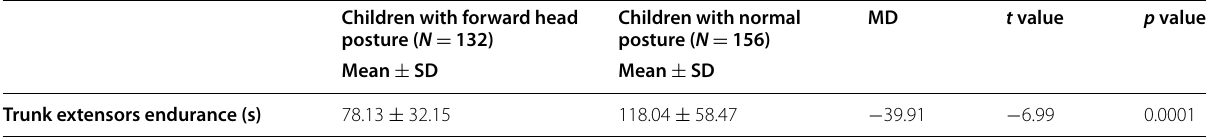
SD Standard deviation, MD Average disparity, p value, the probability value